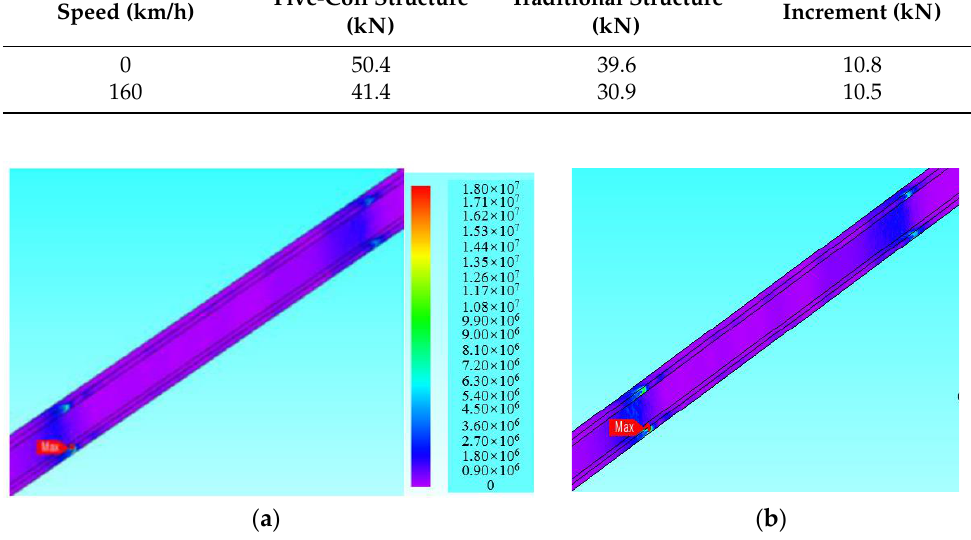
Figure 9. The eddy current of F-shaped rail at different speed: ( a ) 100 km/h; ( b ) 160 km/h.